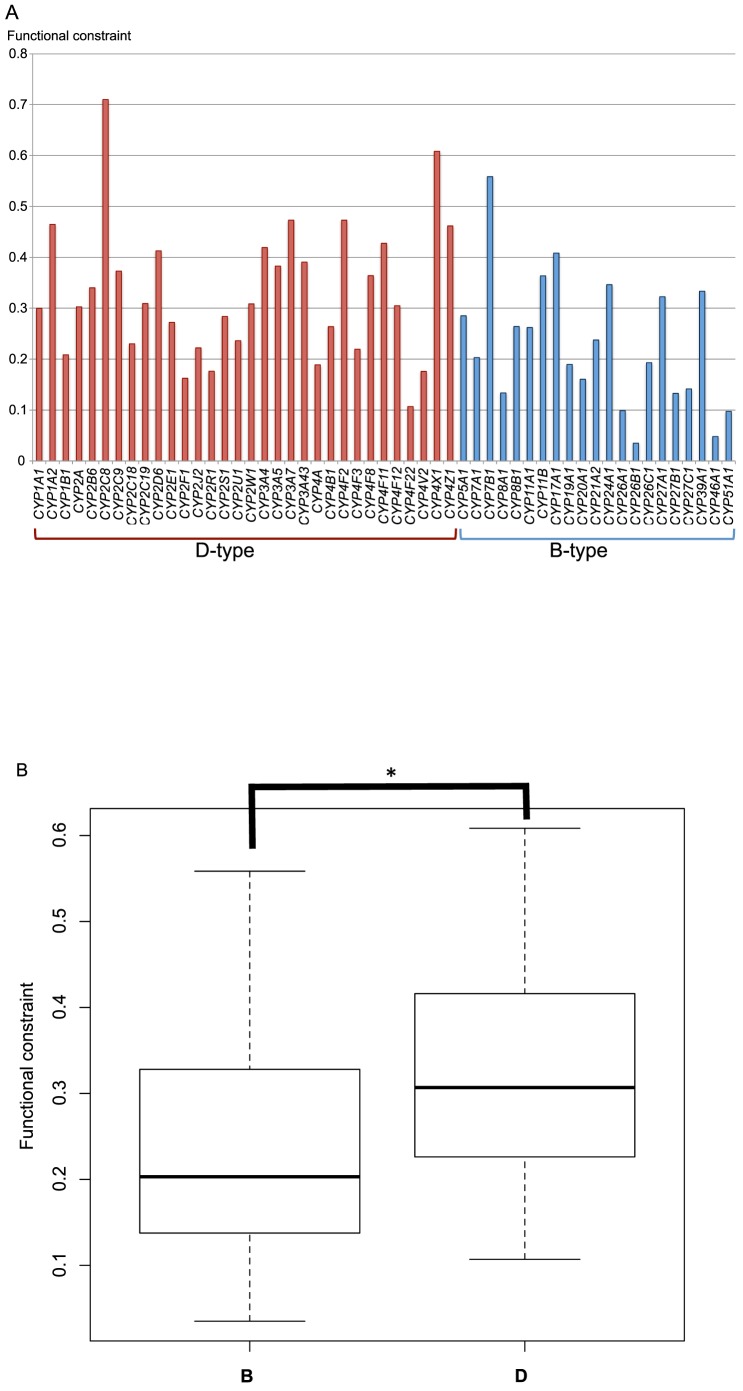
Functional constraint of CYP genes.A) Functional constraint was estimated for each CYP gene. The y-axis shows the functional constraint obtained via the ratio of per-site non-synonymous substitutions to synonymous substitutions (DN/DS). Red bars indicate D-type genes, and blue bars indicate B-type genes. B) Comparison of median values for functional constraints between primate B- and D-type genes. “B” indicates functional constraint of B-type genes, and “D” indicates functional constraint of D-type genes. The P-value was 0.01282 (significance was defined as P<0.05). The P-value was calculated using the Mann–Whitney U test.